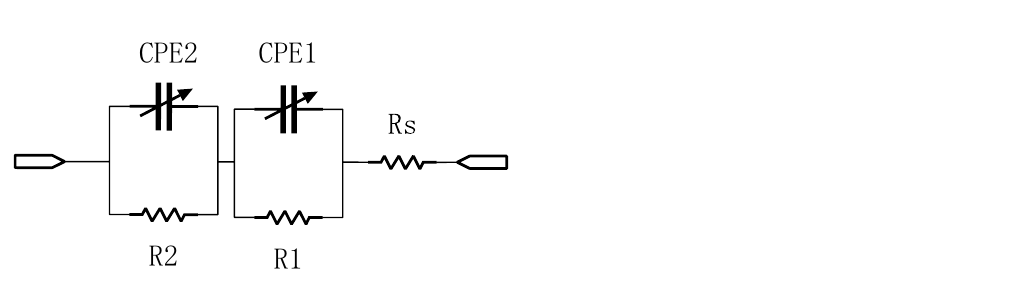
Figure 8. The equivalent circuit.